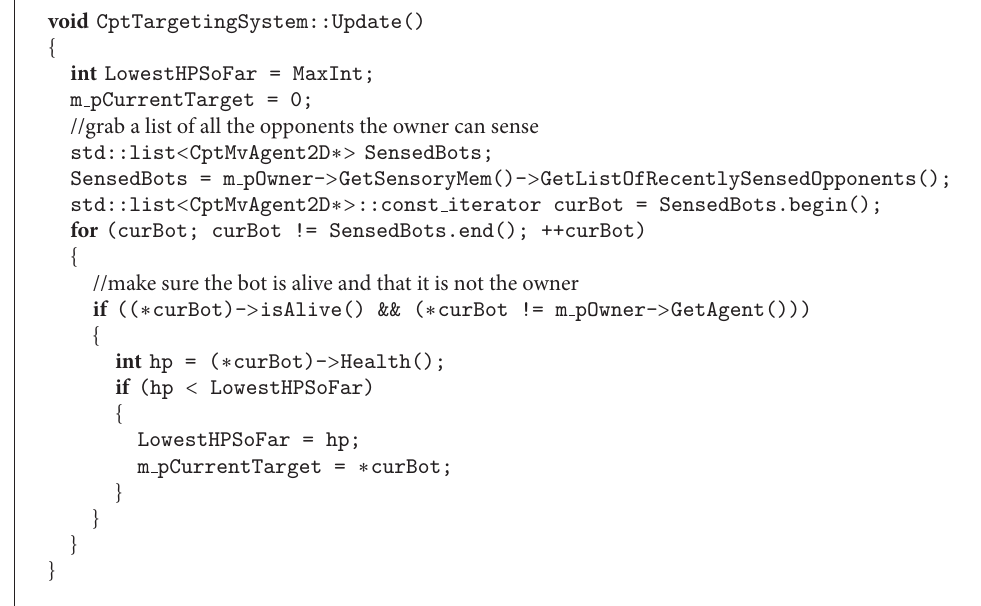
Algorithm 15: Modified target selection in Graven. Health is compared instead of